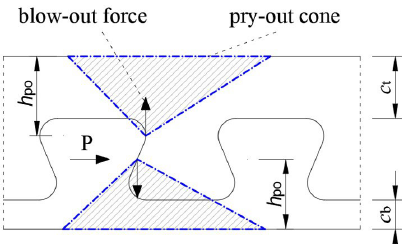
Figure 2. Idealization of concrete pry-out in Crestbond shear